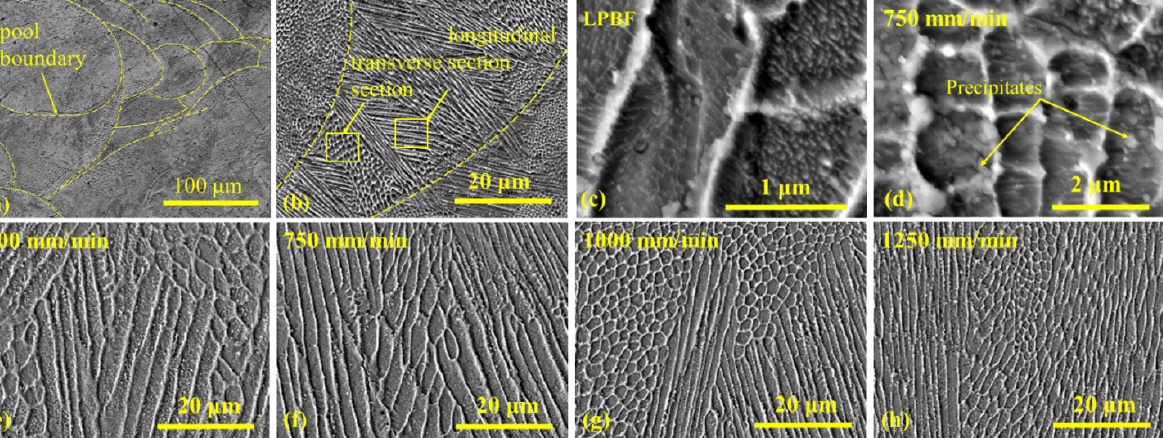
Figure 8. SEM images of LPBF body microstructure ( a – c ) and microstructure of laser processed surfaces without alloying additive ( d – h ): ( a ) overview showing substructure of LPBF specimen due to “point-by-point” building pattern; ( b ) longitudinal and transverse directions of cellular microstructure of LPBF body; cellular microstructure of LPBF at high magnification ( c ); cellular microstructure and dispersive precipitations in the surface processed without boron at 750 mm/min laser speed ( d ); cellular microstructure of laser processed surfaces at 500, 750, 1000 and 1250 mm/min laser speed, respectively ( e – h ).